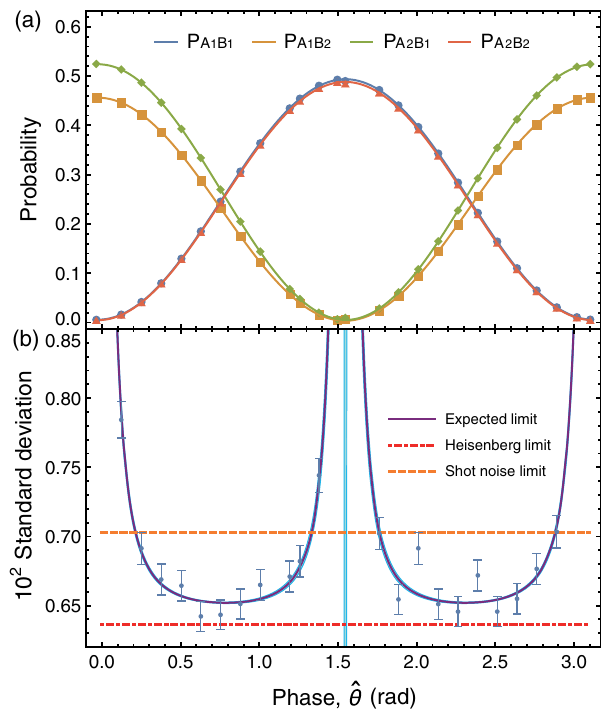
FIG. 5. Experimental results with a linear function of θ = 2 − θ = 2 for a distance of 240 m. (a) Experimental interfer- A B ence fringes of four detection events versus different phase shifts. ˆ θ ^ θ ∈ The horizontal axis represents ¼ ð θ A − θ B Þ = 2 , ½ 0 ; π (cid:2) . (b) Experimental phase standard deviation (purple line) per trial versus different phase shifts. The shaded areas (blue narrow bands) correspond to the 99.7% confidence regions, which are calculated from the uncertainty of the fit parameters. Orange dashed line: theoretical limit for SNL. Red dashed line: theo- retical bound for HL. The error bars of the standard deviations are discussed in the main